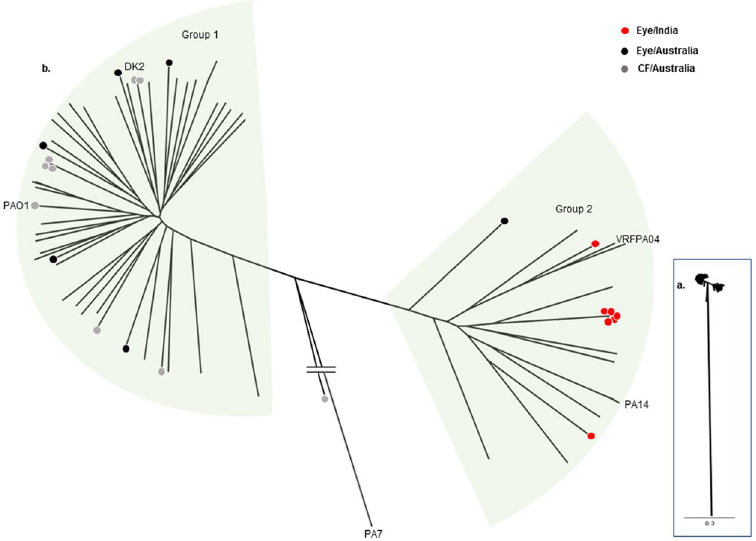
Figure 2. Phylogenetic analysis of Pseudomonas aeruginosa isolates. Maximum likelihood phylogenetic tree built with core genome SNPs based on mapping to the PAO1 excluding SNPs identified in regions that had arisen by recombination. ( a ) The original tree where the scale bars represent the number of substitutions per site. ( b ) Magnified tree showing branches and groups. Strains used in this study are indicated by distinct colour circles. Relative positions of few reference strains are shown, which are P . aeruginosa VRFPA04 , P . aeruginosa UCBPP- PA14 , P . aeruginosa PAO1 , and P . aeruginosa DK2